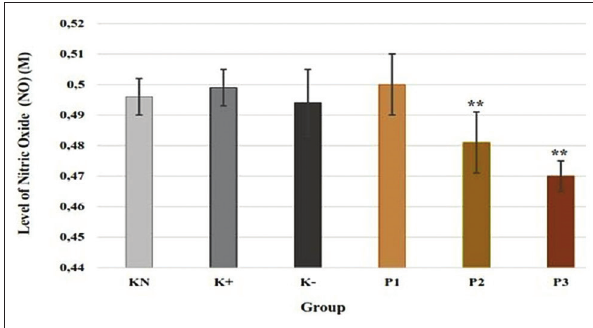
Figure-4: Effect of polysaccharides from Caribena versicolor on level of nitric oxide (M). KN=Normal control, K+=Positive control, K−=Negative control, P1=Administration of polysaccharides (PS) before infection, P2=Administration of PS after infection, P3=Administration of PS before and after infection. Values are represented as means±standard deviation (n=6). **p<0.05 compared to KN group.